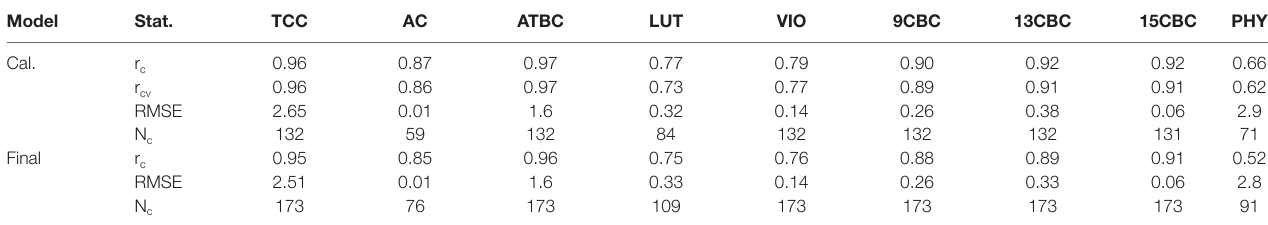
TABle 1 | Calibration statistics of the portable Vis/NIRS spectra analyzed using random forests for total carotenoid content (TCC), all-trans β-carotene (ATBC), violaxanthin (VIO), lutein (LUT), 15-cis beta-carotene (15CBC), 13-cis beta-carotene (13CBC), alpha-carotene (AC), 9-cis beta-carotene (9CBC), and phytoene (PHY) carotenoids in cassava roots.